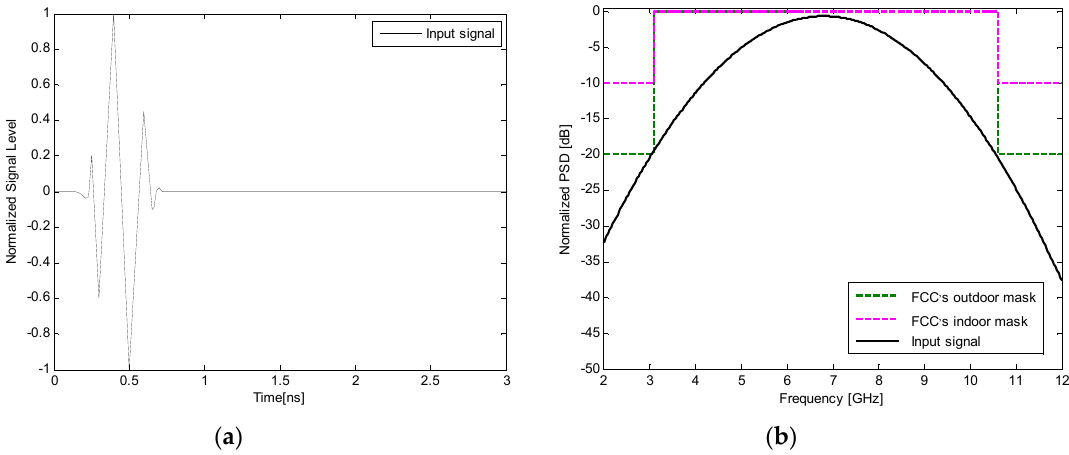
Figure 16. ( a ) Normalized input pulse; ( b ) power spectrum density and Federal Communication Commission (FCC) mask for indoor and outdoor mask.